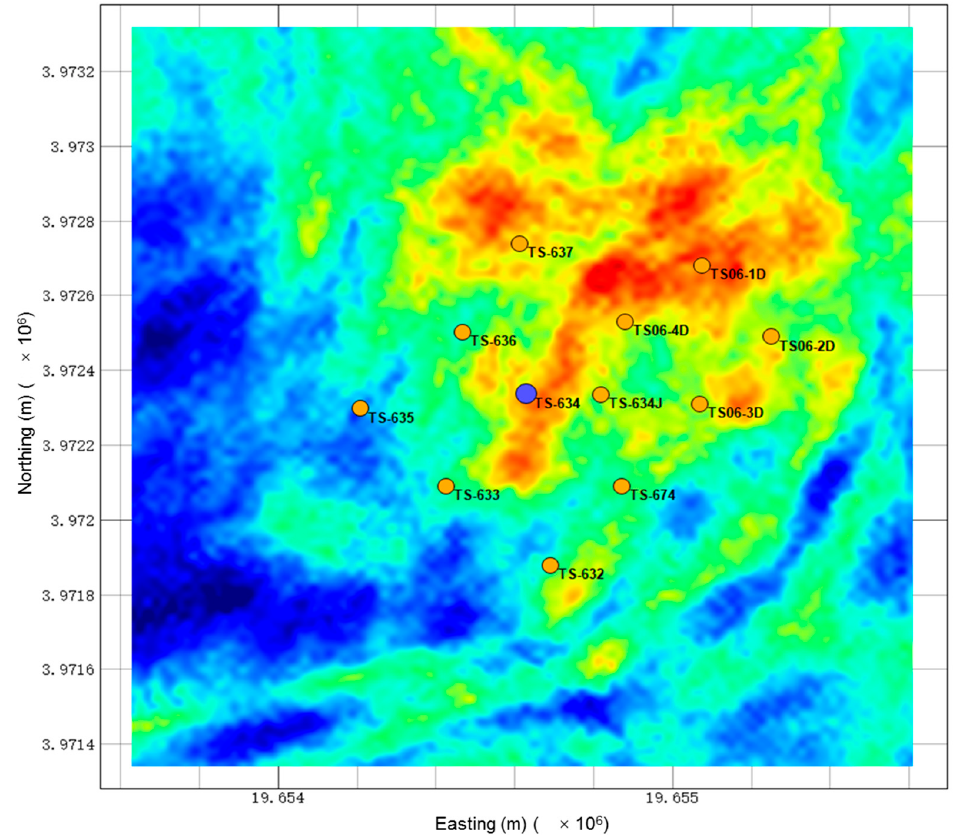
Figure 10. Passive seismic monitoring results in the work area.